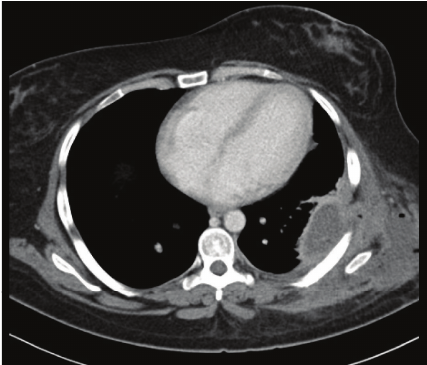
Figure 1: Axial CT scan of the chest demonstrating the intrapleural collection with pockets of air consistent with empyema.